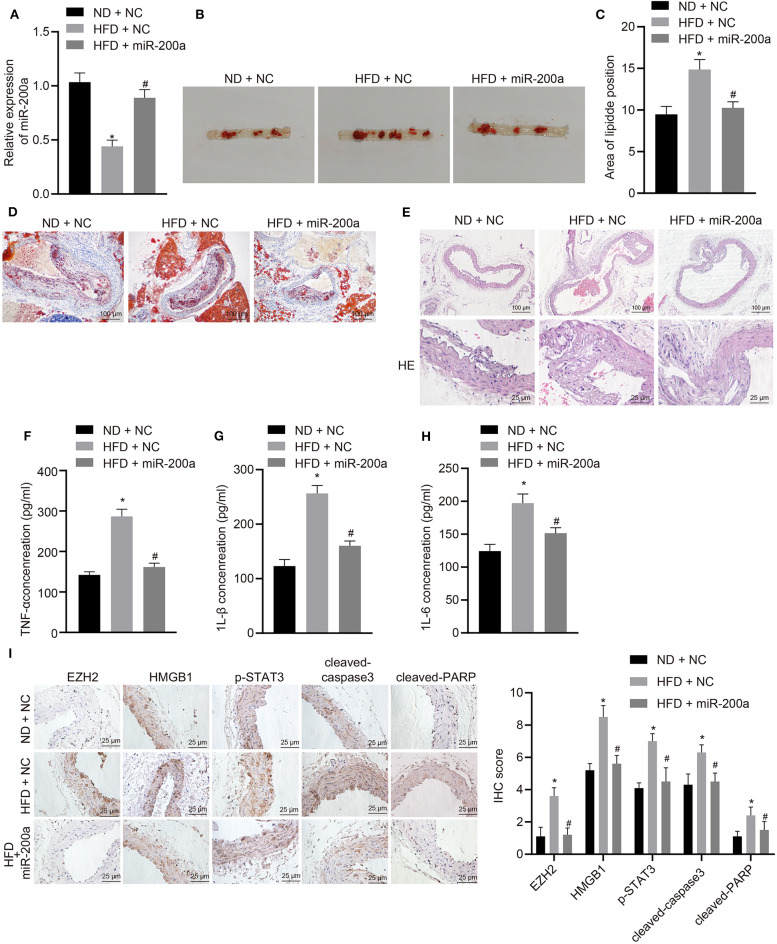
The antiatherosclerotic role of miR-200a in atherosclerotic mice. ApoE−/− mice were fed with a high-fat diet (with ND + NC as control) and injected with miR-200a agomir (with HFD + NC as control). (A) miR-200a expression (normalized to U6) in arterial tissues of ApoE−/− mice (n = 10) determined using RT-qPCR. (B) Oil red O staining images of arterial tissues of ApoE−/− mice. (C) Total aortic lesions detected by oil red O staining. (D) Lipid deposition of arterial tissues of ApoE−/− mice detected by oil red O staining (×100), red indicating lipid-rich plaque. (E) Atherosclerotic lesions in arterial tissues of ApoE−/− mice detected by HE staining (×100; × 400). (F–H) Concentration of TNF-α, IL-1β, and IL-6 in the serum of ApoE−/− mice measured by ELISA. (I) Expression levels of EZH2, p-STAT3, STAT3, HMGB1, cleaved-caspase3, and cleaved-PARP in the arterial tissues of ApoE−/− mice measured by immunohistochemical staining (×400). *(relative to normal diet-treated mice) and #(relative to high-fat diet-treated mice) indicate p < 0.05 by one-way ANOVA/Tukey's post-hoc test.